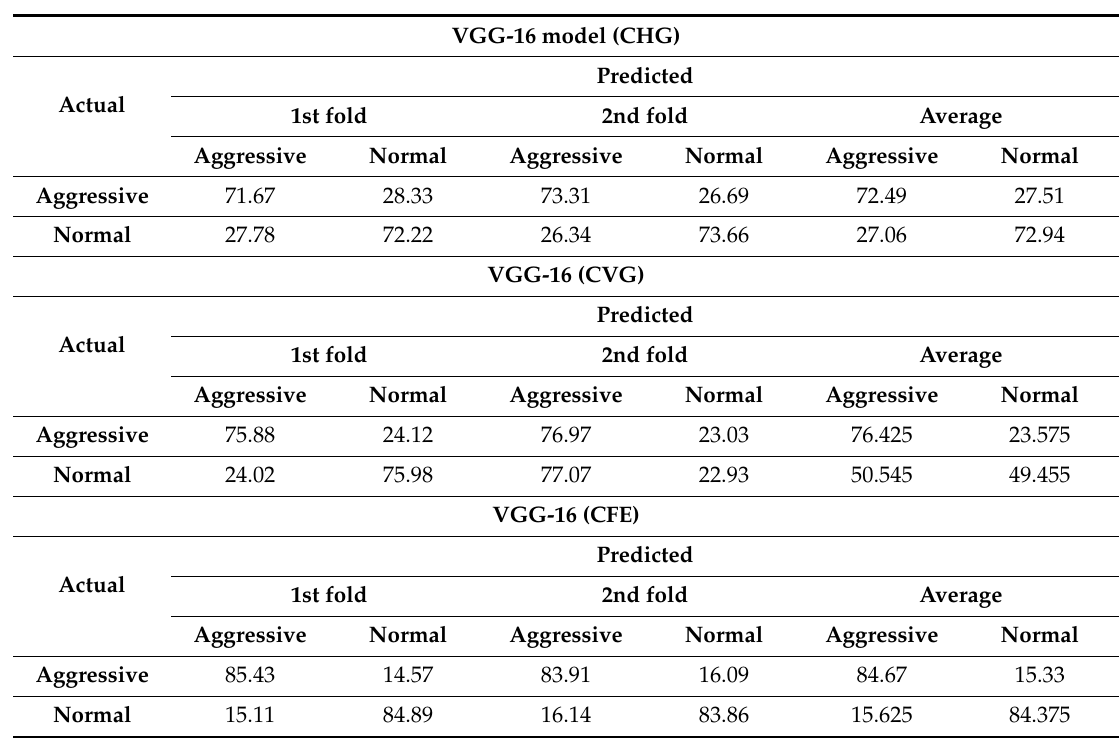
Table 6. Classification accuracies by VGG- face 16 model